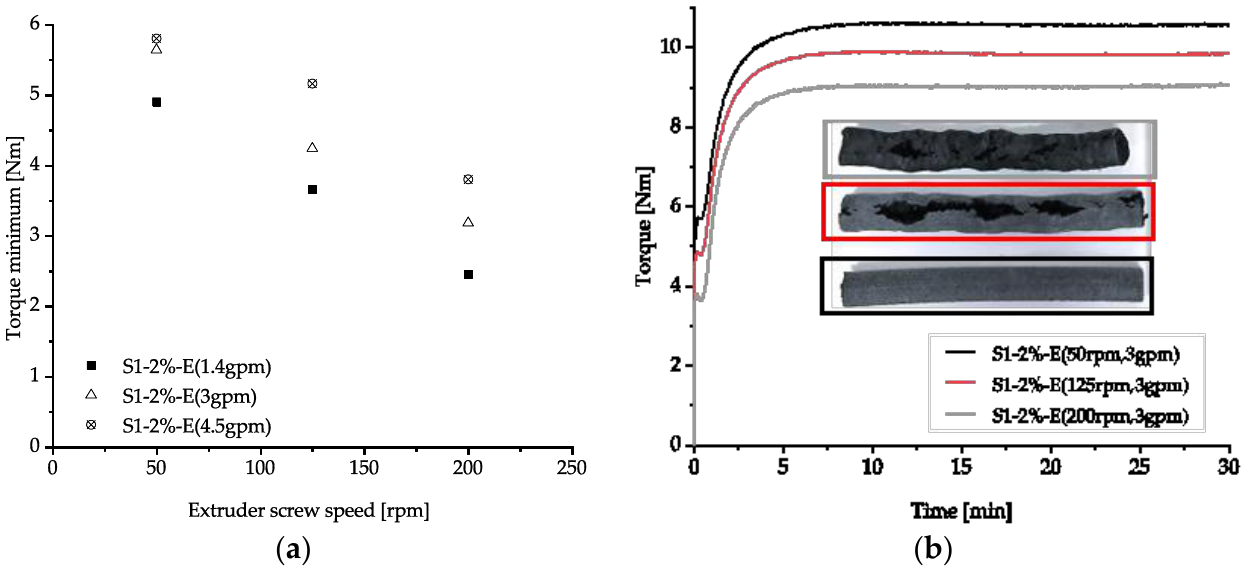
Figure 5. Torque minimum of S1-2%-E as a function of screw speed and flow rate ( a ) and rheometer curves recorded at 180 °C of S1-2%-E (3 gpm) with pictures of the ext ruded material ( b ).